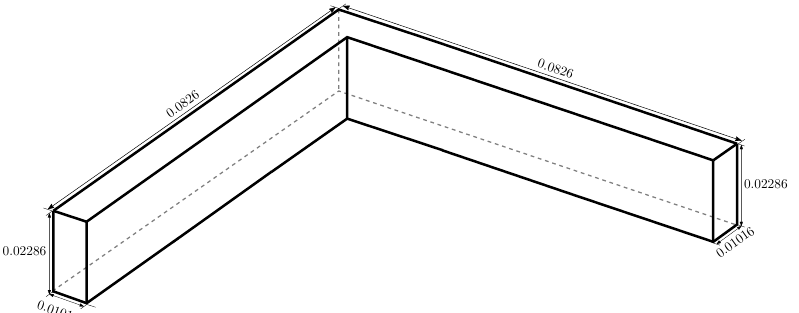
Figure 17. WR-90 bend waveguide used in Section